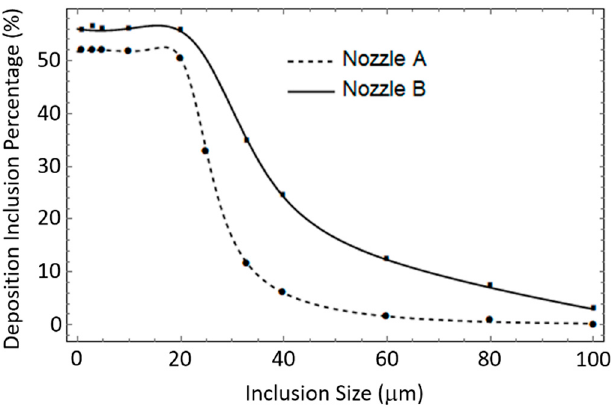
Figure 12. Deposition inclusion percentage for Nozzle A and B.